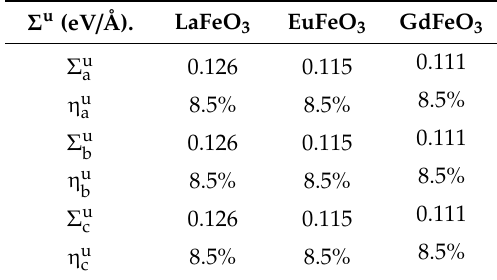
Table 7. Ultimate stresses and ultimate strain of RFeO 3 (R = La, Eu, Gd) in a, b, and c directions under cubic